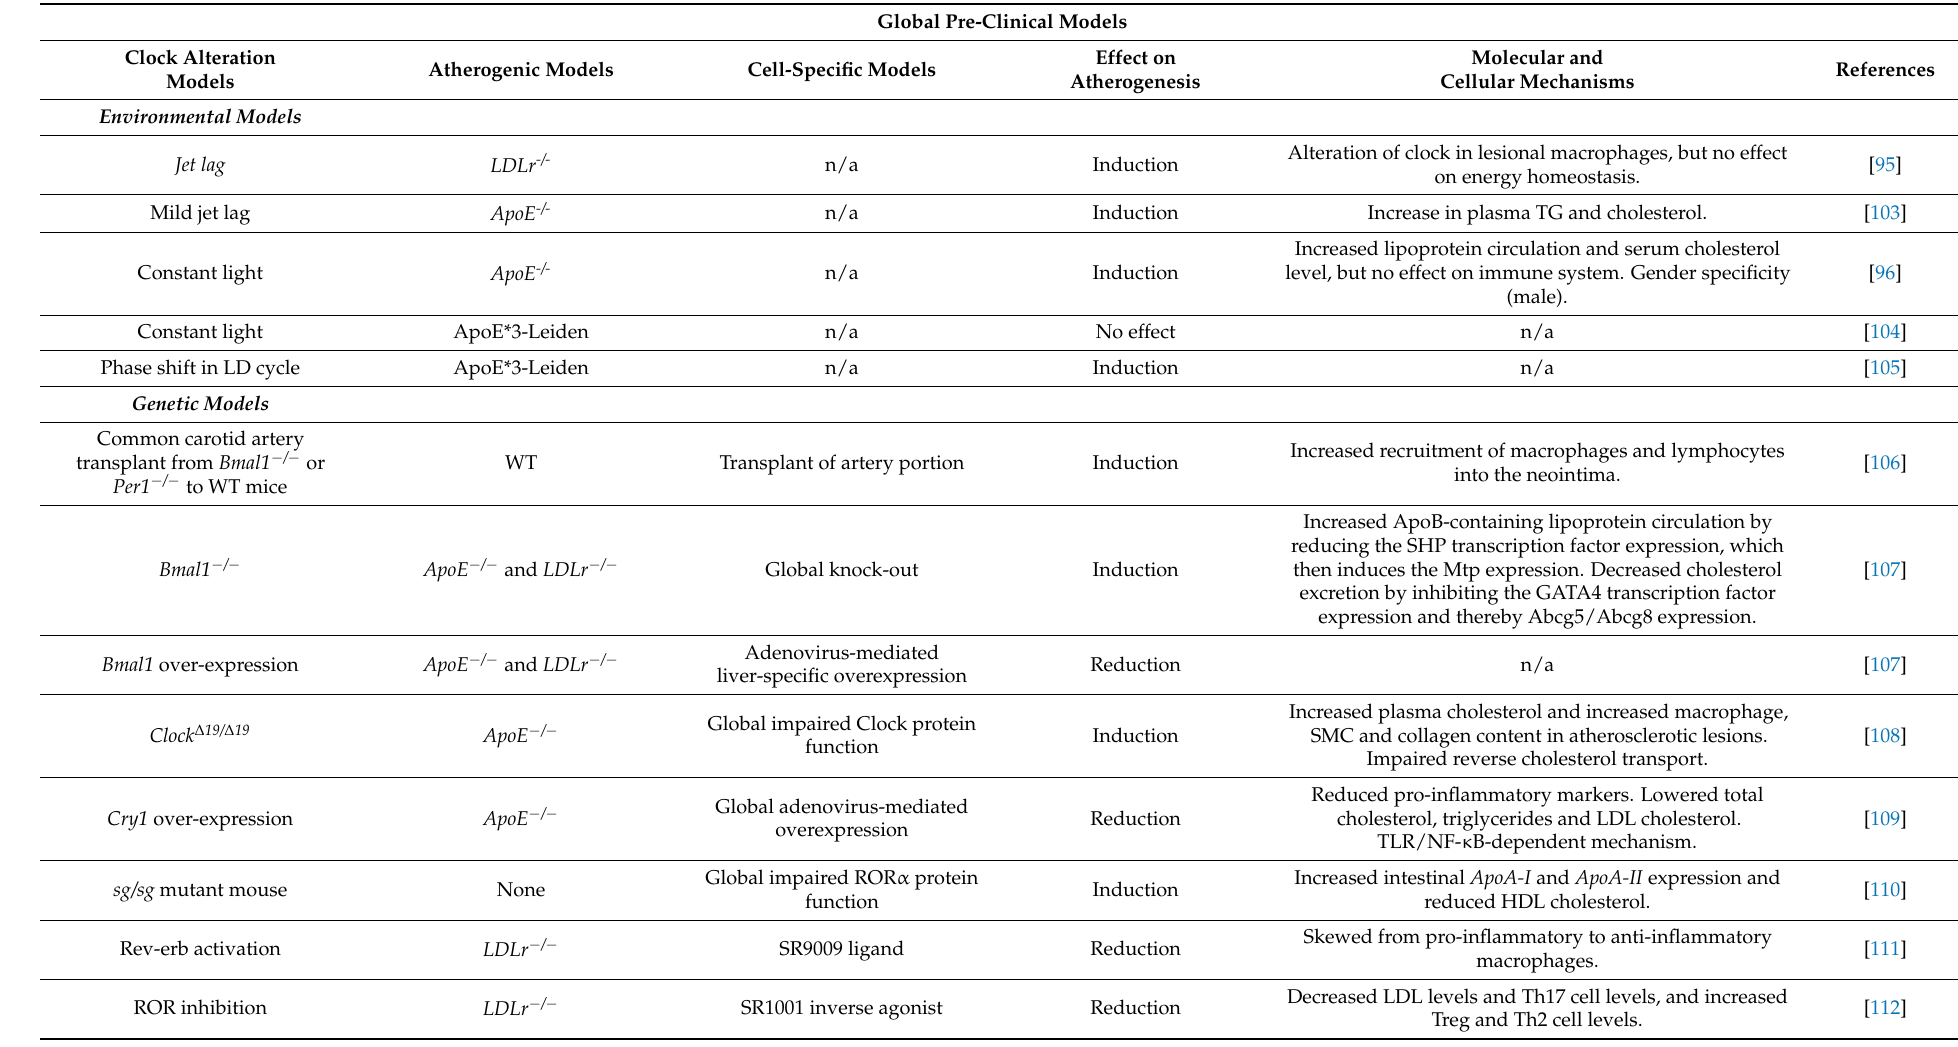
Table 2. Pre-clinical models of global clock